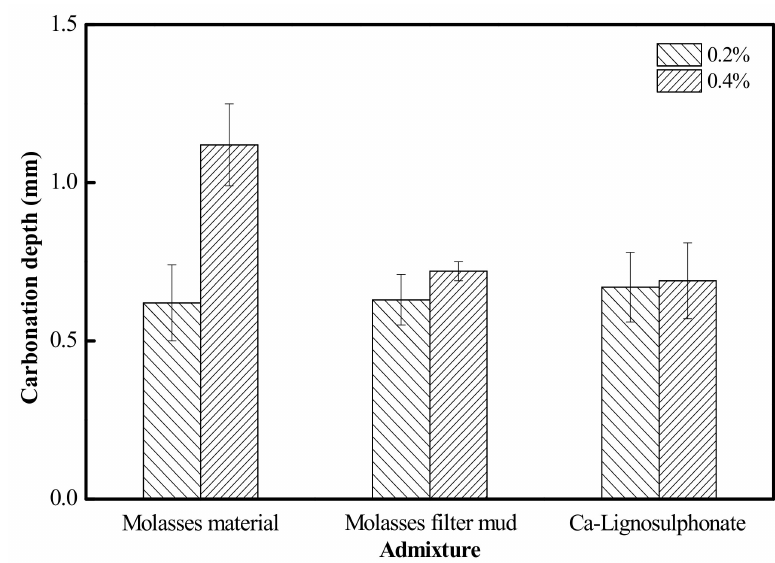
Figure 7. Effects of admixture on carbonation